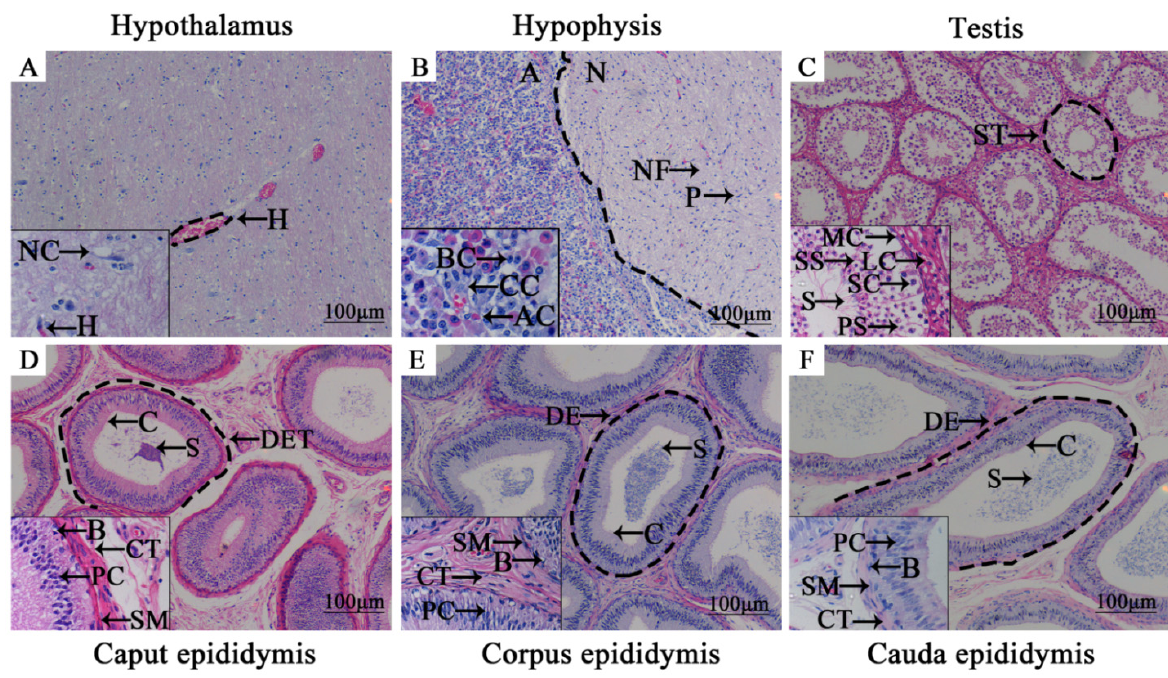
Figure 1. H&E staining of HPG tissues of an adult male yak (4 years old). ( A – F ) H&E staining of hypothalamus, hypophysis, testis, caput epididymis, corpus epididymis and cauda epididymis tissues, respectively (100 × ). The box in the lower left corner is a partial enlarged view (400 × ) . H, hematocyte; NC, neurogliocyte; A, adenohypophysis; N, neurohypophysis; P, pituicyte; AC, acidophilic cells; BC, basophilic cells; CC, chromophobe cells; NF, nerve fibers; ST, seminiferous tubule; MC, myoid cells; LC, interstitial cells; SC, spermatogonium; PS, primary spermatocyte; SS, secondary spermatocyte; S, spermatozoon; DET, ductuli efferentes testis; B, basal cells; PC, principal cells; SM, smooth muscle cells; CT, connective tissue; DE, ductus epididymidis.